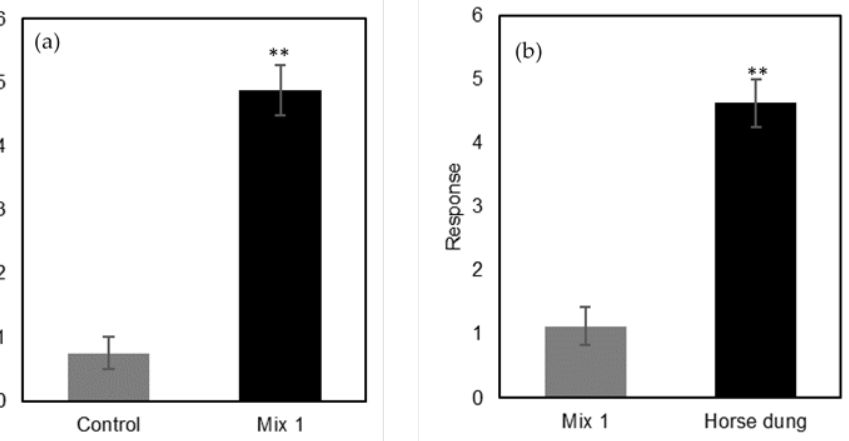
Figure 9. Olfactory response of B. bison to individual compounds ( n = 48 beetles; *, p < 0.05 and ns, not significant, as determined by Wilcoxon’s signed-rank test).